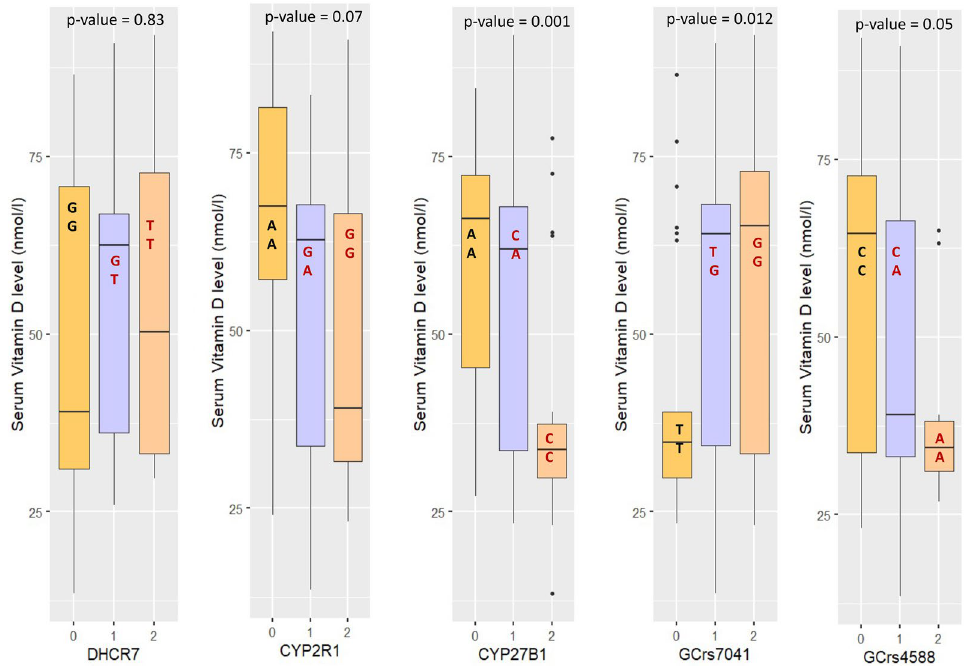
Figure 3. Levels of vitamin-D in the study groups according to the genotypes (p-values were generated from Kruskal–Wallis test).